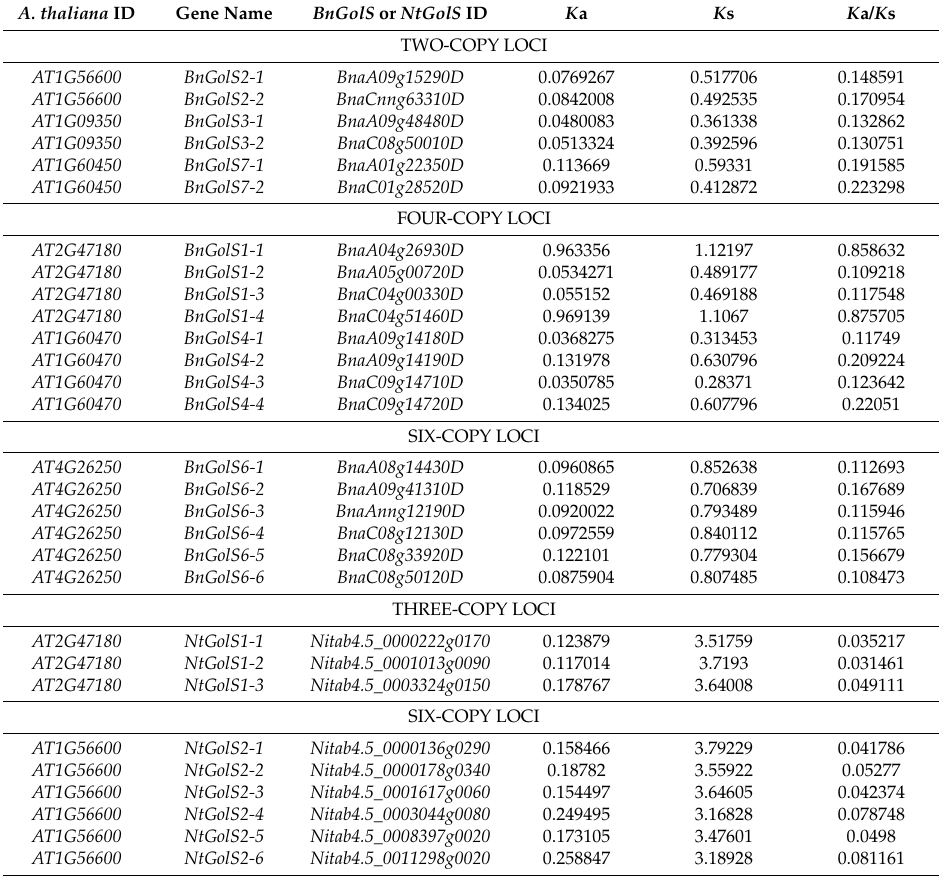
Figure 4. Distribution of BnGolS gene family members along the B. napus chromosomes and synteny map of GolS genes from A. thaliana B. napus , B. rapa and B. oleracea. ( A ) Chromosomal information for BnGolS genes was obtained from the Brassica database and was mapped to B. napus chromosomes. Syntenic relationships are indicated with connecting lines; ( B ) Genes located within the B. napus genome that are syntenic with genes of A. thaliana , B. rapa and B. oleracea are indicated by connecting lines. Table 2. Nucleotide substitution rates for BnGolS and NtGolS genes.